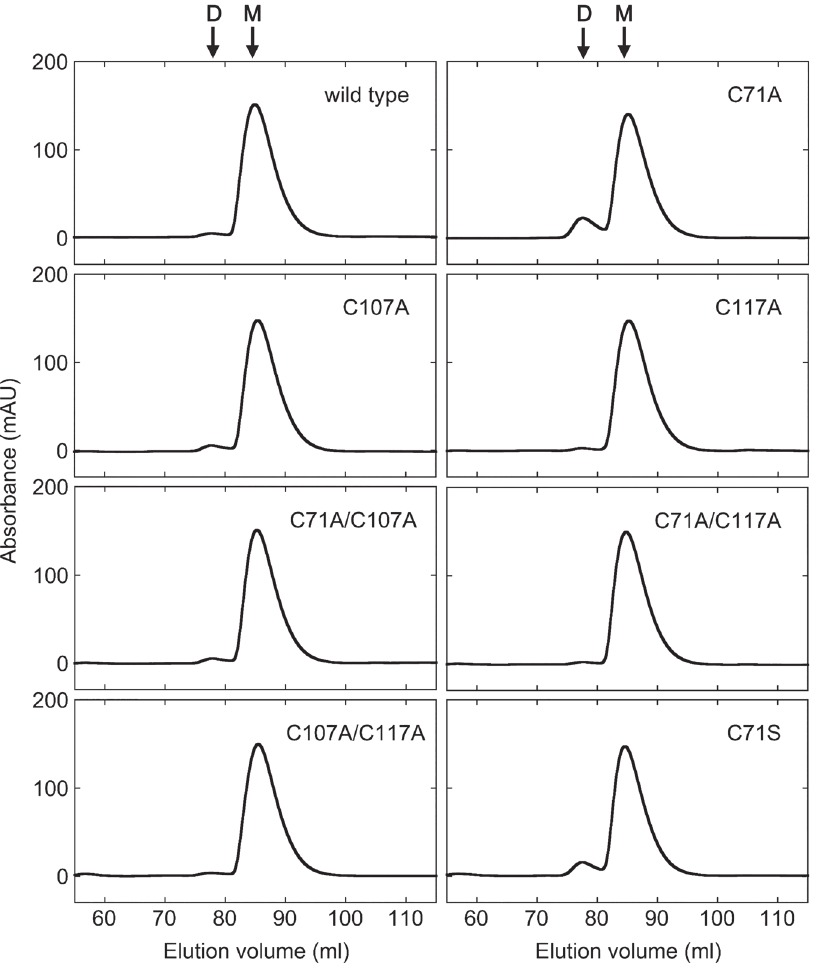
Fig 3. Size exclusion chromatography elution profiles of the wild type and mutant ADs. D and M denote the elution volumes of a dimer and a monomer,